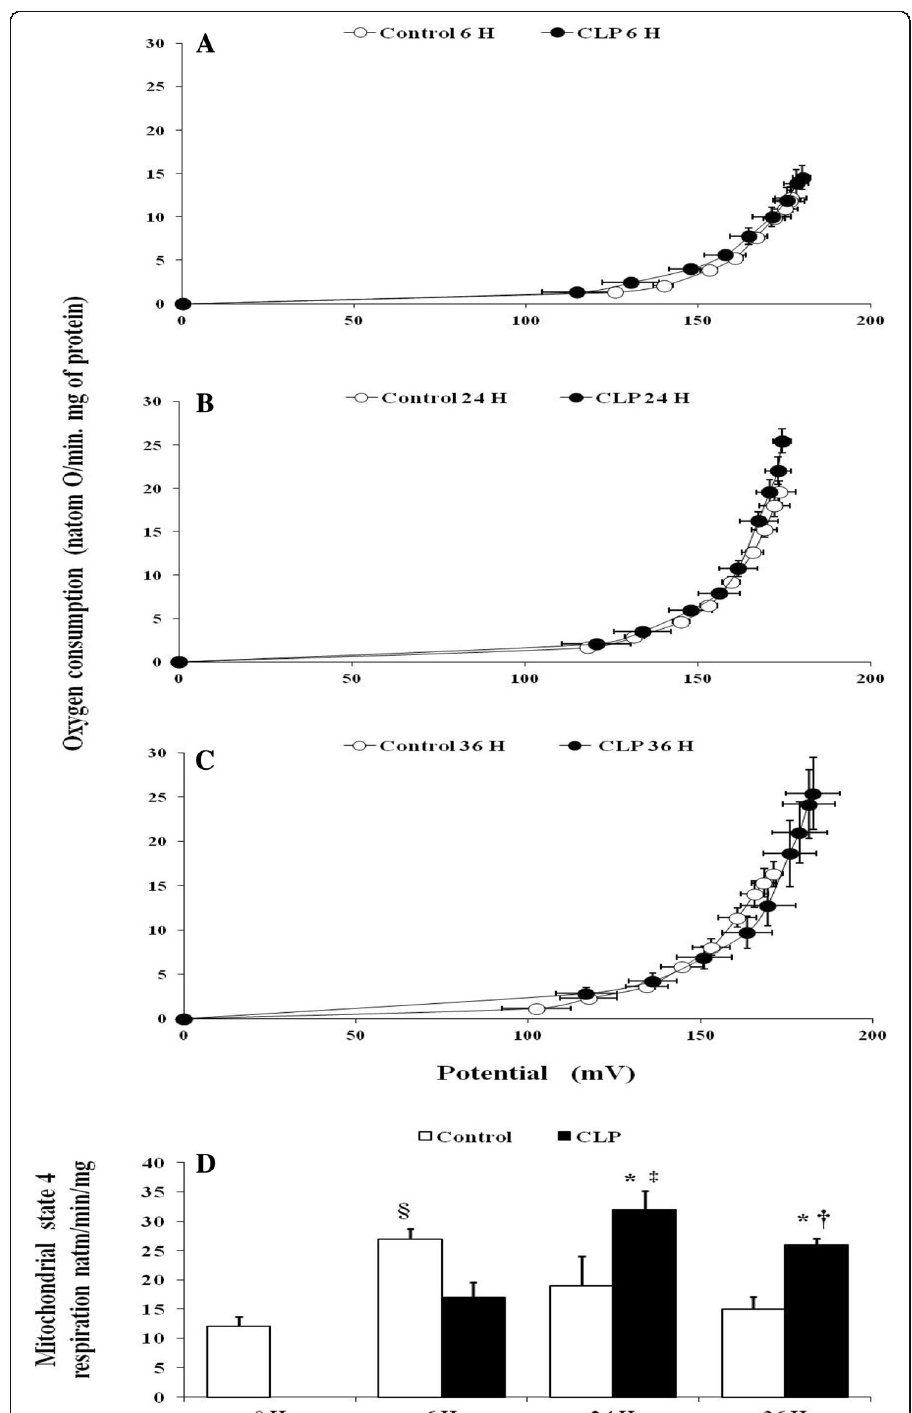
Fig. 4 (See legend on next